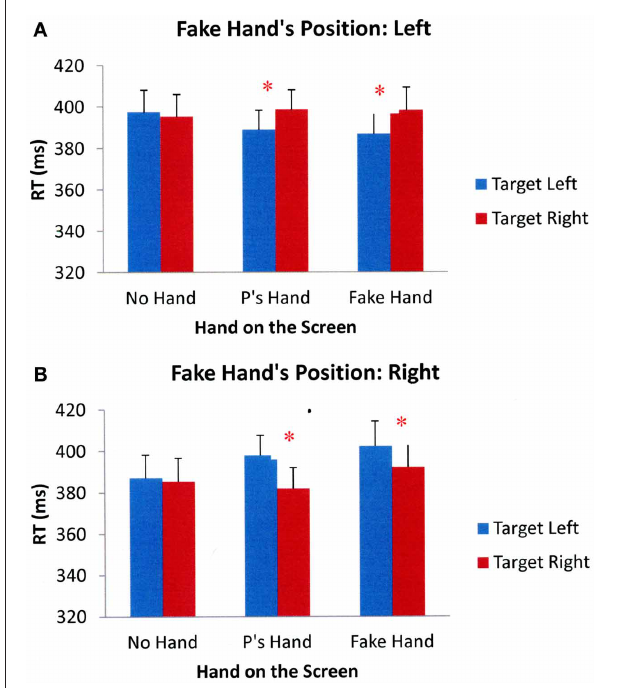
FIGURE 6 | Mean reaction times across all participants in different Experimental conditions of Experiment 3 when a fake hand was positioned on the participant’s left (A) and right (B). Error bars represent standard errors of the means. (Note: P’s = Participant’s). ∗ p < 0 . 05.